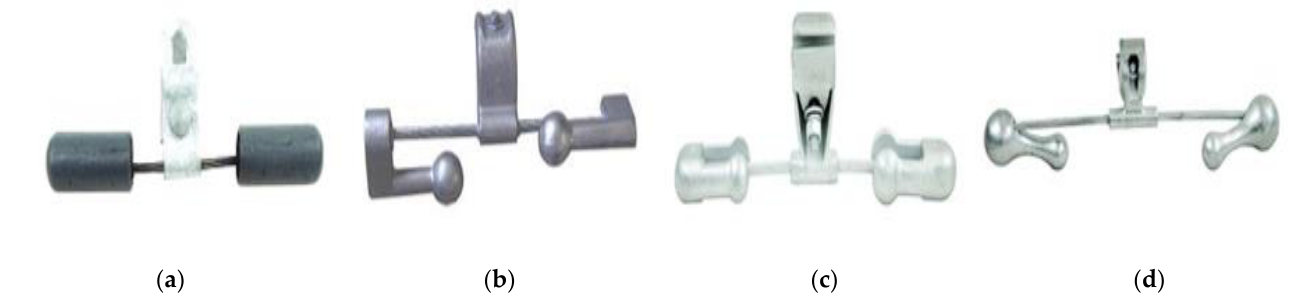
Figure 2. Four common types of vibration dampers: ( a ) FD; ( b ) FDZ; ( c ) FDY; ( d ) FFH.